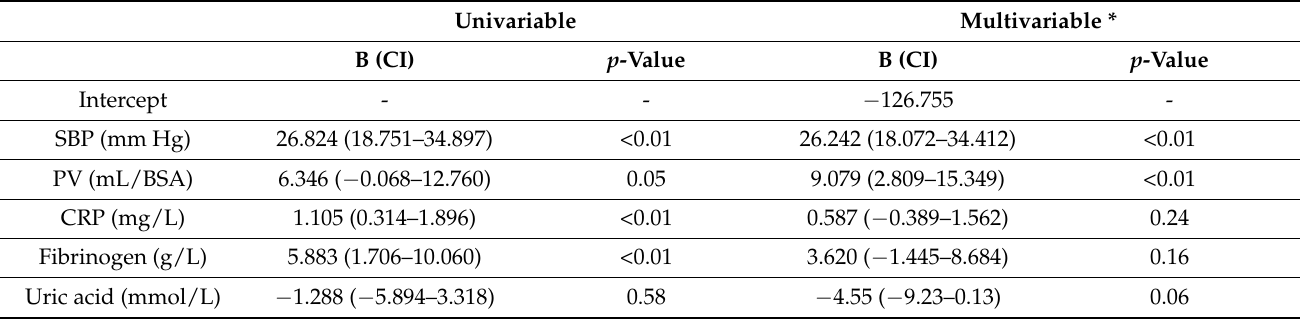
Table 5. Univariable and multivariable linear regression model with LVMi as outcome using trans- formed data set. The regression coefficients were used to formulate a formula: LVMi = − 126.76